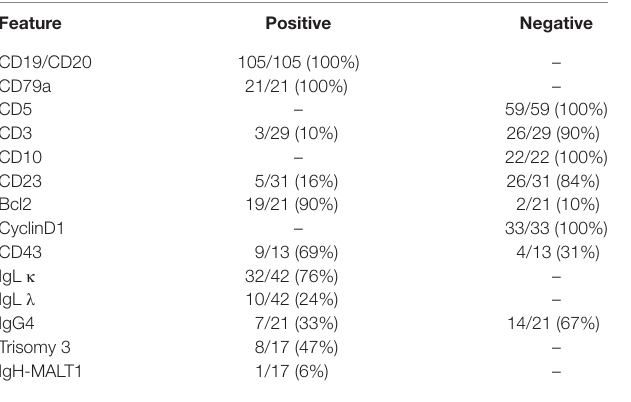
TABLe 2 | Phenotypic and cytogenetic markers in cases with dural marginal zone lymphoma. Feature